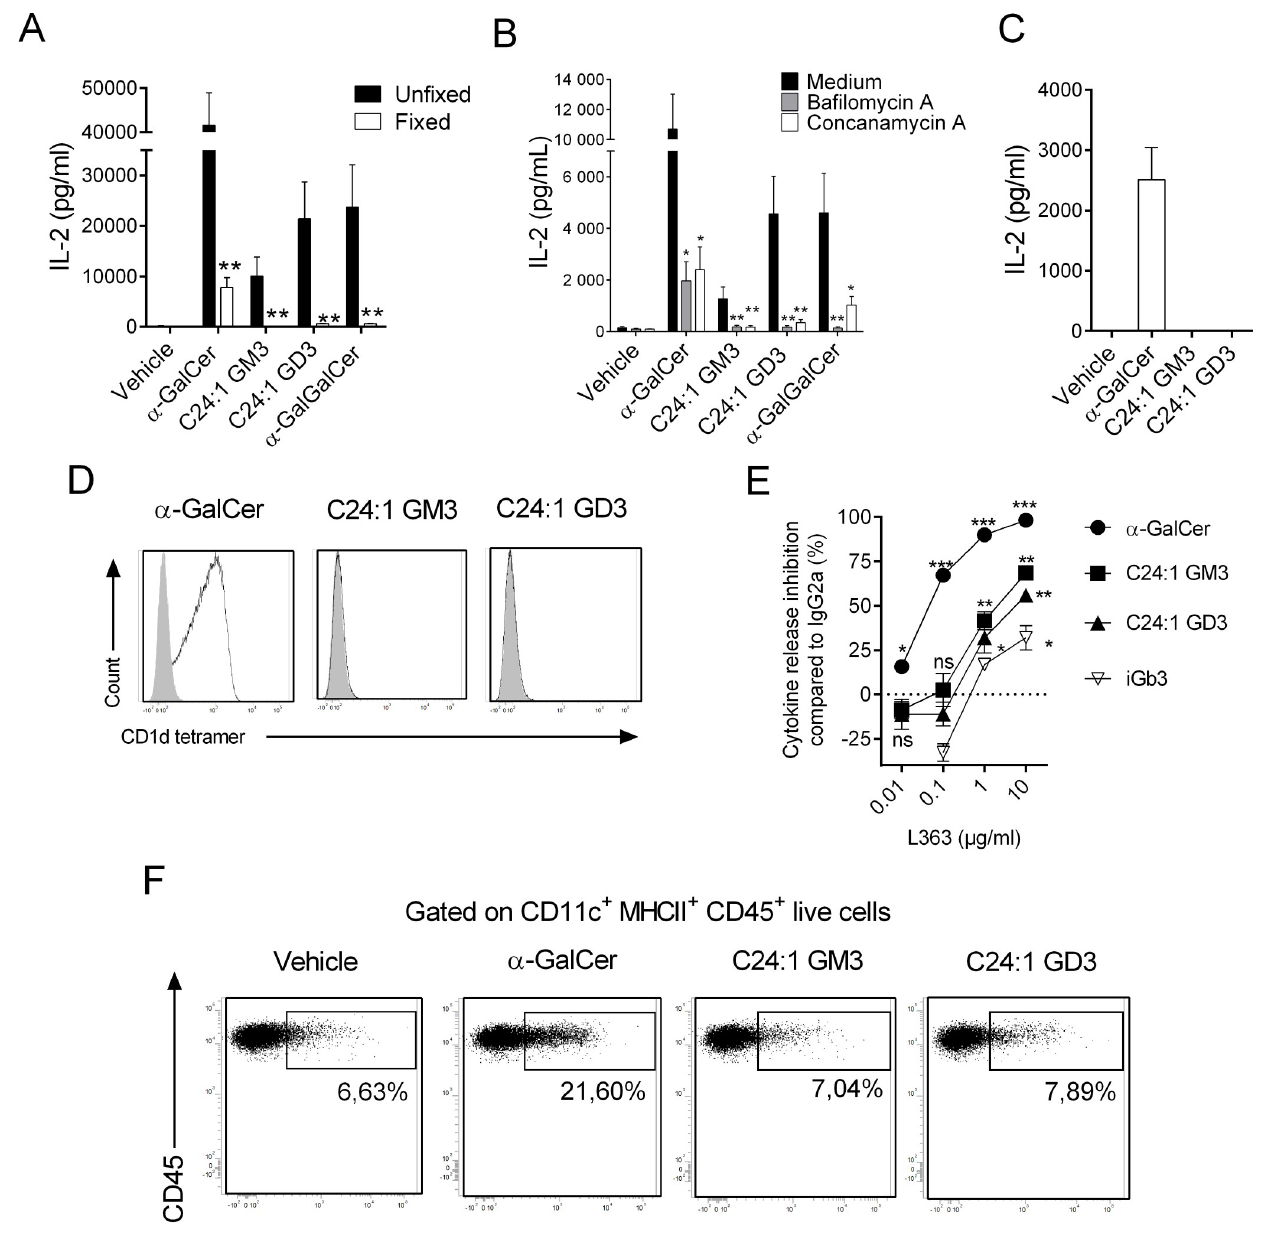
Fig 6. Influence of the DC intracellular pathway on the recognition of gangliosides by the i NKT TCR. (A) Fixed or unfixed DCs were cultured with the mouse i NKT hybridoma DN32.D3 in presence of purified glycolipids (23 pM for α -GalCer and 6.5 μ M for gangliosides) or vehicle for 24 h. (B) Lysosomal acidification inhibitor–pretreated or not DCs were cultured with DN32.D3 in presence of glycolipids or vehicle. (C) Plate-bound CD1d dimers loaded with various glycolipids were cultured with DN32.D3 hybridoma for 24 h. (A–C) i NKT cell activity was evaluated as in Fig 5A. Data represent the means ± SEM of two experiments performed in triplicates. (D) DN32.D3 hybridoma was stained with PE-conjugated CD1d tetramers loaded or not with various glycolipids. Dot plots are representative of one experiment out of two. (E) DCs were cultured with DN32.D3 in presence of purified glycolipids (23 pM for α -GalCer, 1.5 μ M for iGb3, and 6.5 μ M for gangliosides) or vehicle for 24 h with increasing concentrations of L363 mAb or isotype control. NKT cell activity was evaluated as in Fig 5A. The dose-dependent L363 inhibition normalized to isotype control for each glycolipid is represented. Means ± SEM of two experiments performed in triplicates are shown. (F) Unloaded or glycolipid-loaded DCs were subjected to L363 mAb or Ig-control staining. Dot plots are representative of one experiment out of two for each condition. �� P < 0.01; � P < 0.05. Underlying data used in the generation of this figure can be found in S1 Data. α -GalCer, α -galactosylceramide; CD1d, cluster of differentiation 1d; DC, dendritic cell; Ig, immunoglobulin; iGb3, isoglobotrihexosylceramide; i NKT, invariant natural killer T; mAb, monoclonal antibody; NKT, type I natural killer T cell; ns, not significant; PE, phycoerythrin; TCR, T-cell receptor.